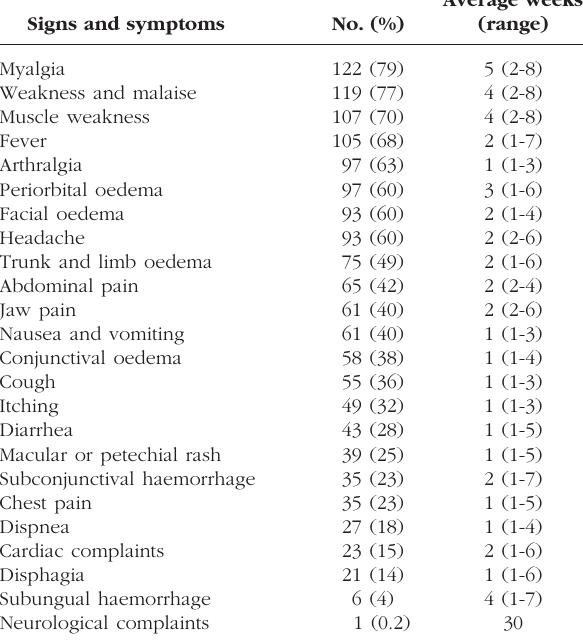
Table I. – Signs and symptoms of patients with confirmed trichi- nellosis (n = 154) and their frequency and